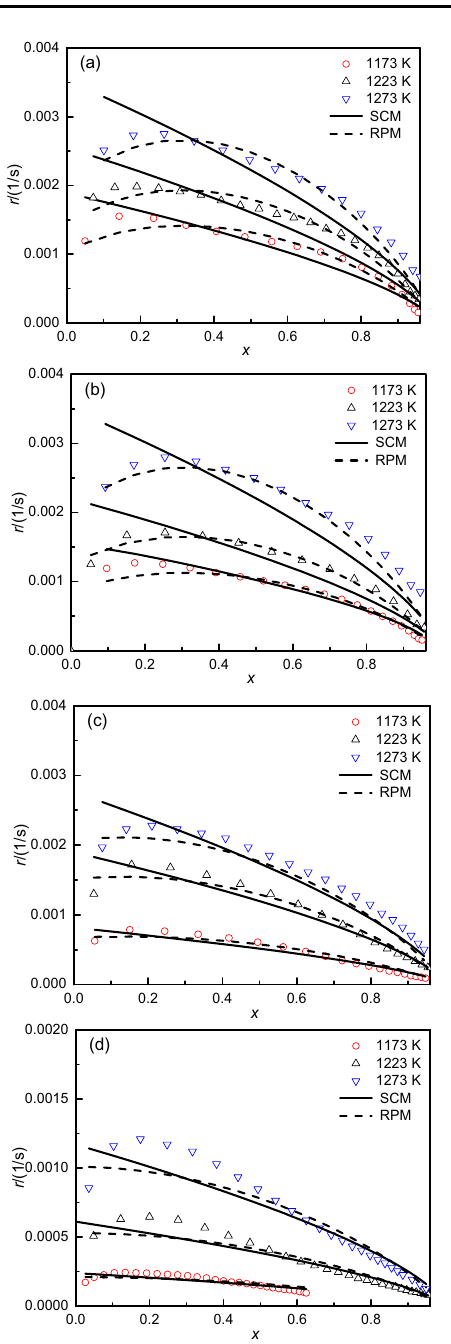
Fig. 6 Comparison of SCM- and RPM-predicted reaction rates to experimental values: a Py1073; b Py1173; c Py1273; and d MW